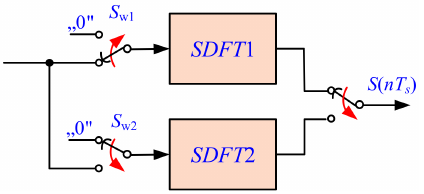
Figure 8. The working principle of SSDFT is described in Table 3.